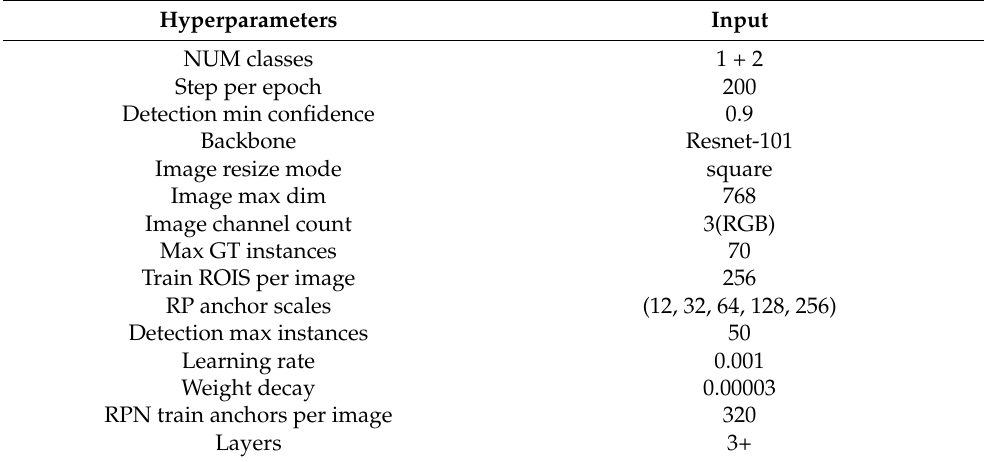
Table 3. Values of Mask R-CNN hyperparameters.